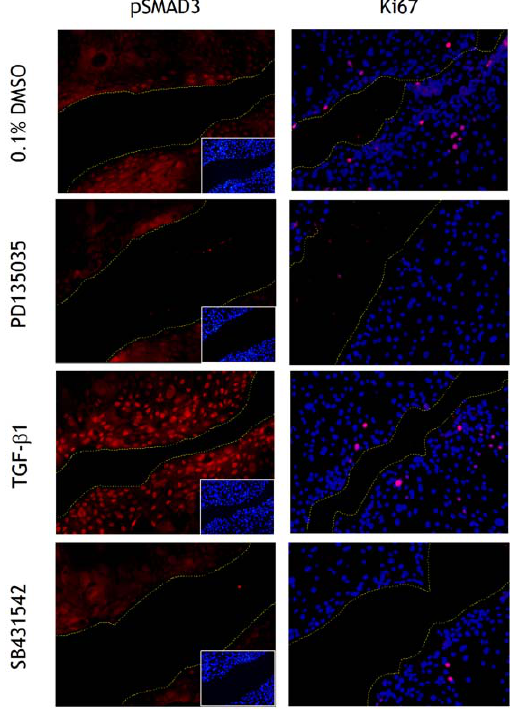
Figure 6. Localisation of phospho-SMAD3 in scratch-wounded differentiated NHU cell cultures. NHU cells were induced to differentiate by 7 day culture with ABS/Ca 2 + prior to treatment with DMSO (0.1%, vehicle control), TGF b 1 (2 ng/ml), SB431542 (3 m M) or PD153035 (1 m M) for 3 hours and then scratched. Cells were maintained in treatments for 8 hours post-wounding and formalin fixed before immunofluorescence labelling as described in the Materials and Methods. Picture inserts or merged images show the respective Hoechst 33258 nuclear stain. Yellow lines indicate wound margins. Scale bar: 100 m